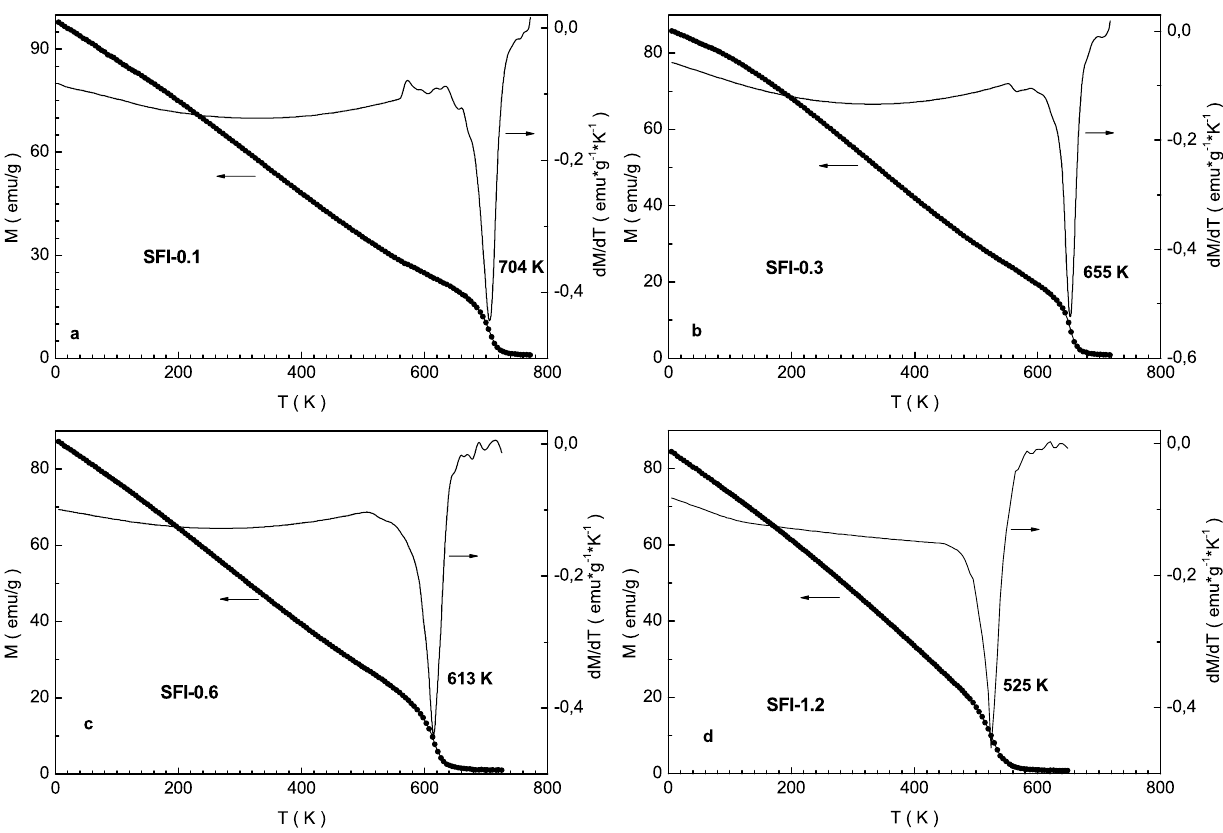
Figure 3. Graphs of magnetization (left axis) and magnetization derivative (right axis) vs. temperature in 1 T for the samples SFI-0.1 ( a ), SFI-0.3 ( b ), SFI-0.6 ( c ) and SFI-1.2 ( d